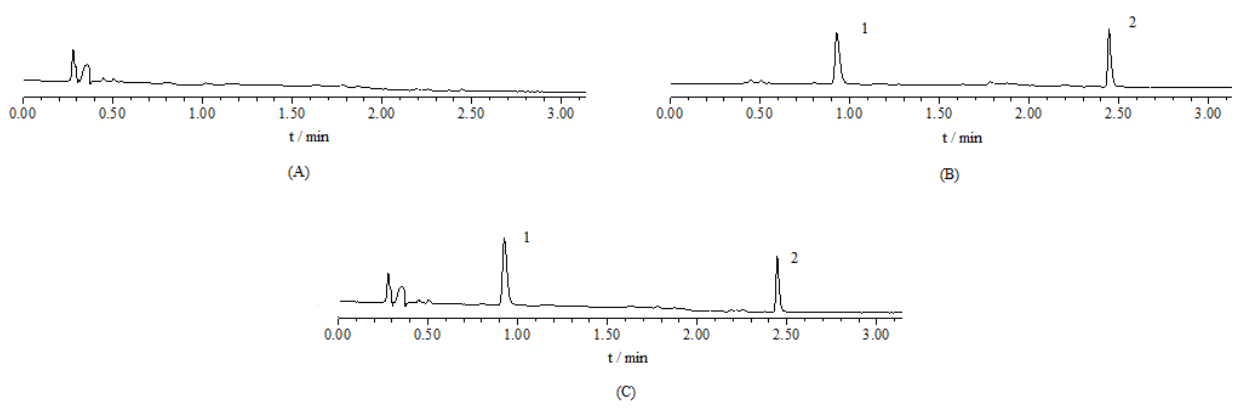
Figure 3. UPLC elution profile of blank control intestinal perfusate ( A ), celastrol (2) and internal standard ( B ), test solution of celastrol ( C ). Testosterone was used as an internal standard (1).